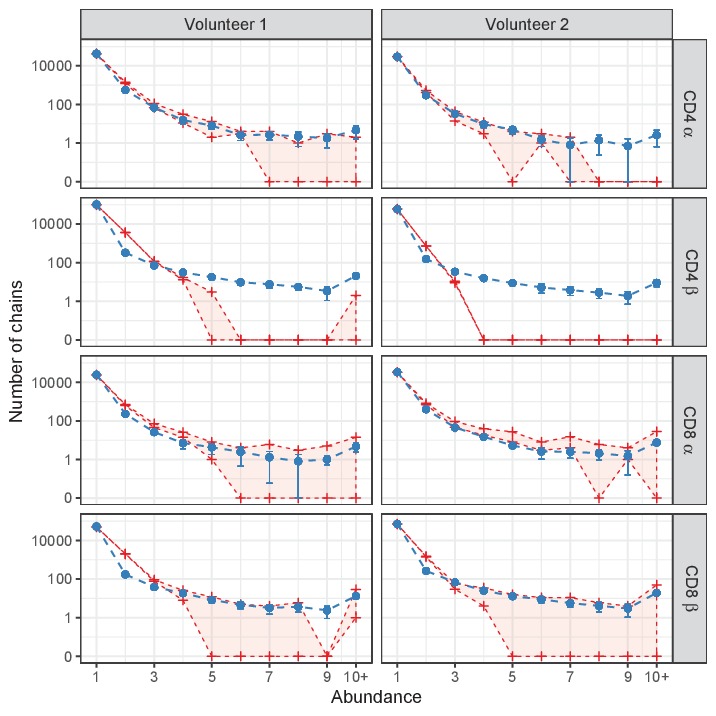
Prediction of power-law model (exponent 2.3) for single sample data.Red lines indicate abundance of TCRα and TCRβ sequences, both without (top) and with cleaning of overlap with memory (bottom). Blue lines represent model prediction for the abundance of α and β chains (blue dashed line, error bars indicate standard deviation over 10 simulations, note the different predictions between the volunteers due to different sample sizes). Sequences represented with 10 or more UMIs are grouped ('10+'). Due to the impact of sampling multiple RNAs from the same cell (Section 'Subsampling to exclude inflated abundance through multiple RNA contributions by single cells'), the predictions under-predict the number of doublets, especially for β chains. Apart from this, the model fits well to the ‘uncleaned’ data in most cases, but the cleaned data under-represents abundant clones, suggesting that several clones shared between memory and naive represent genuine abundant naive clones. The only exception is for CD4+ TCRβ, where we observe much fewer large clones than the model predicts.